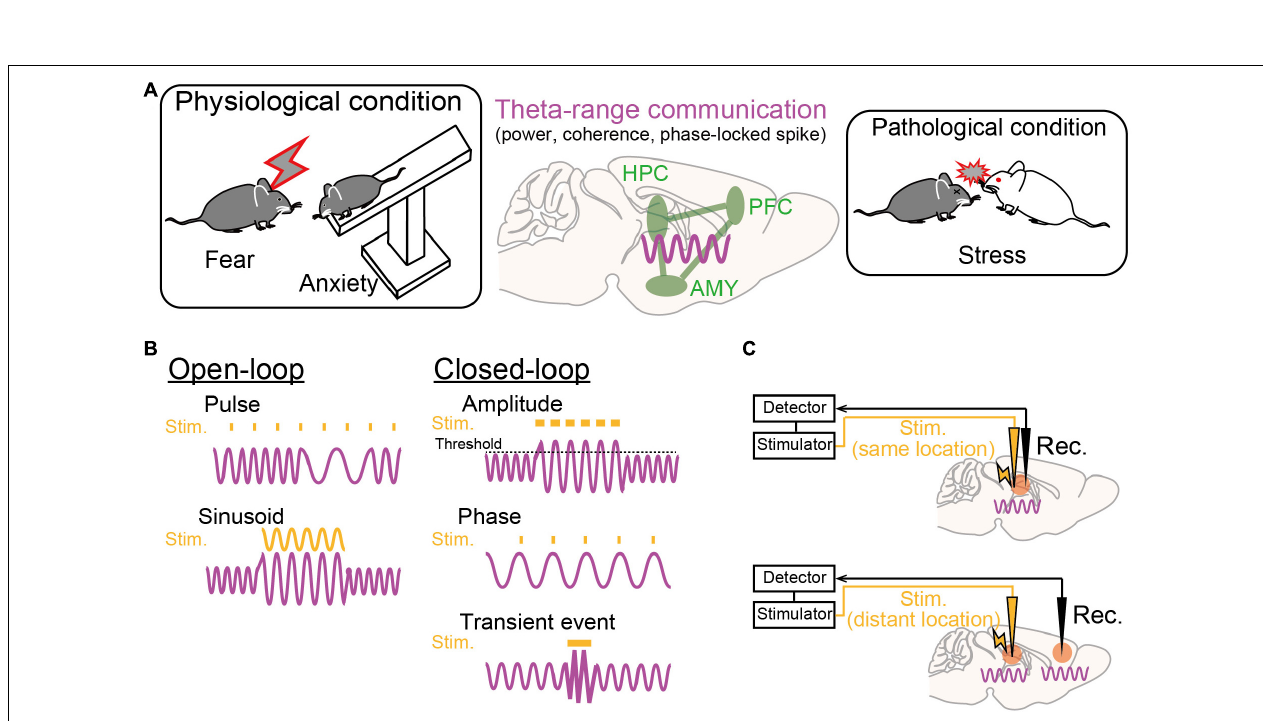
FIGURE 2 | Theta-range oscillations as a target of oscillotherapeutics. (A) Recent studies suggest that theta-range (4–12 Hz) oscillations in the HPC-PFC-AMY circuit are crucial for emotional behavior and susceptibility to stress. (B) Examples of stimulation patterns (orange) upon brain oscillatory signals (magenta) in the open-loop and closed-loop systems. (C) (Top) Closed-loop stimulation is applied to the brain region where a target brain signal is recorded. (Bottom) Closed-loop stimulation is applied to a brain region that is different from the brain region where a target signal is recorded.